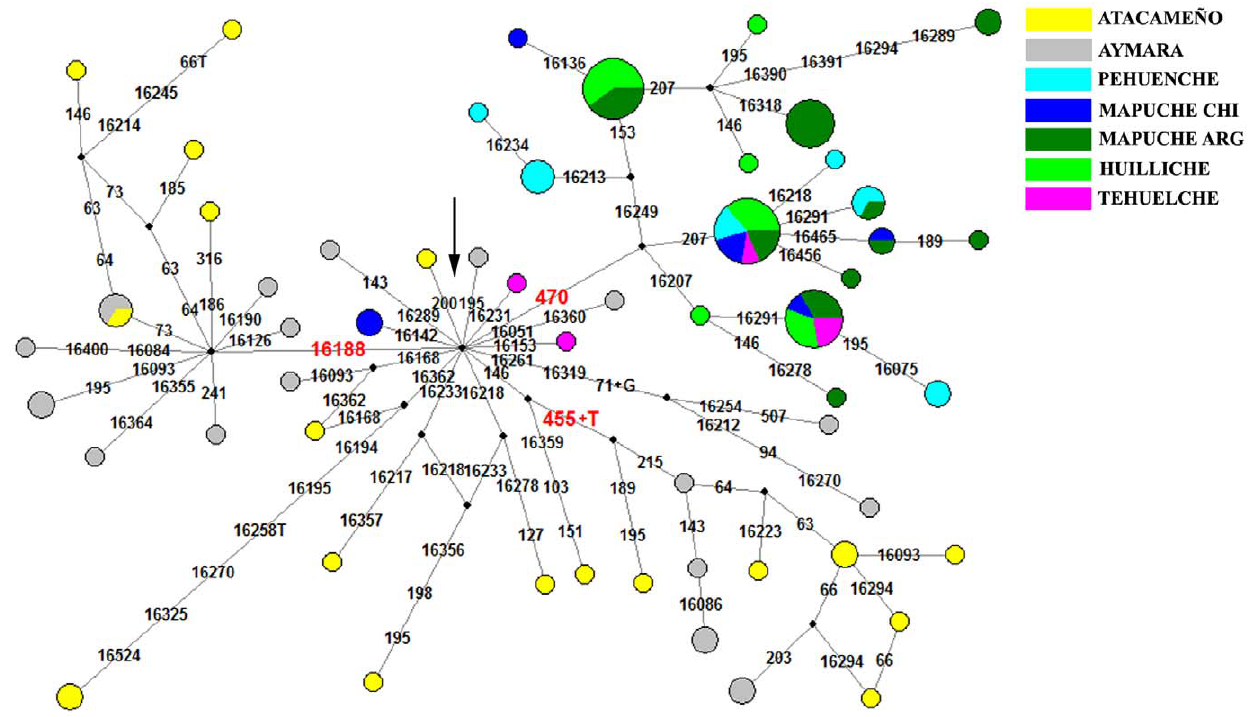
Figure 3. Network for the B2 haplogroup. The arrow shows the B2 nodal, characterized by rCRS differences at 16183C-16189-16217-073-263- 315 + C-499. We show also the new lineage B2l, characterized by the B2 core plus the 470 polymorphism. The northern haplotypes characterized by the 16188 polymorphism and the 455 + T insertion are also noted.